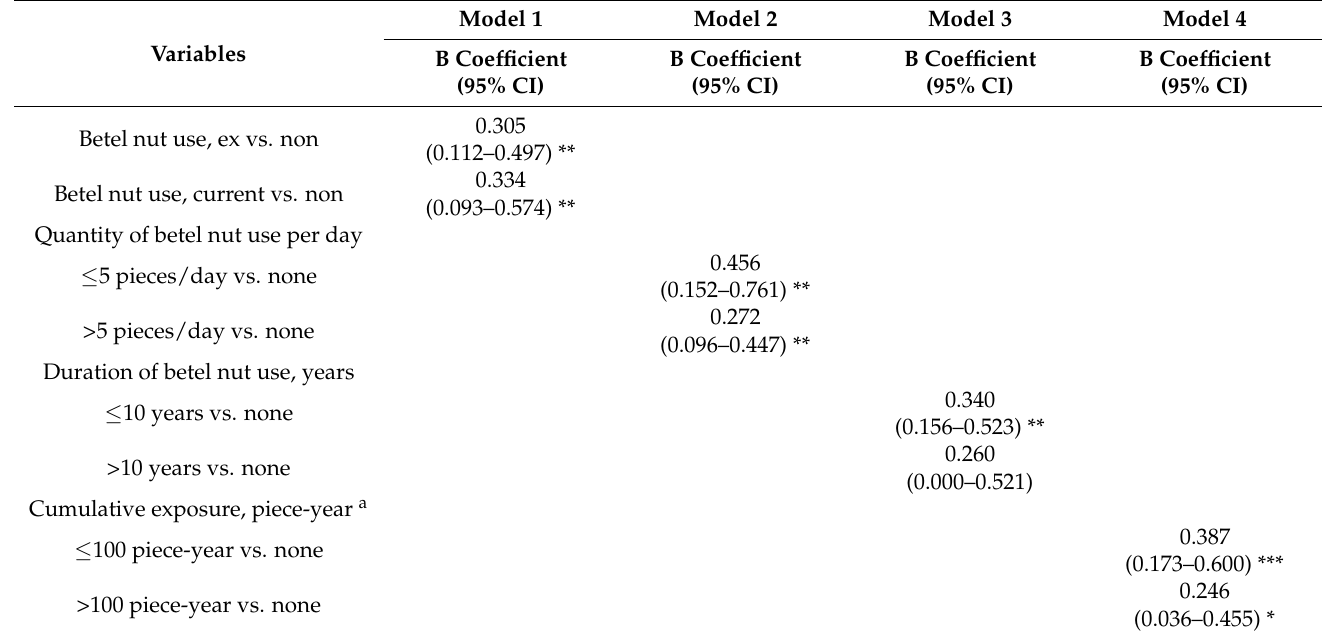
Table 3. Linear regression model for NAFLD fibrosis score and betel nut chewing among patients with NAFLD.